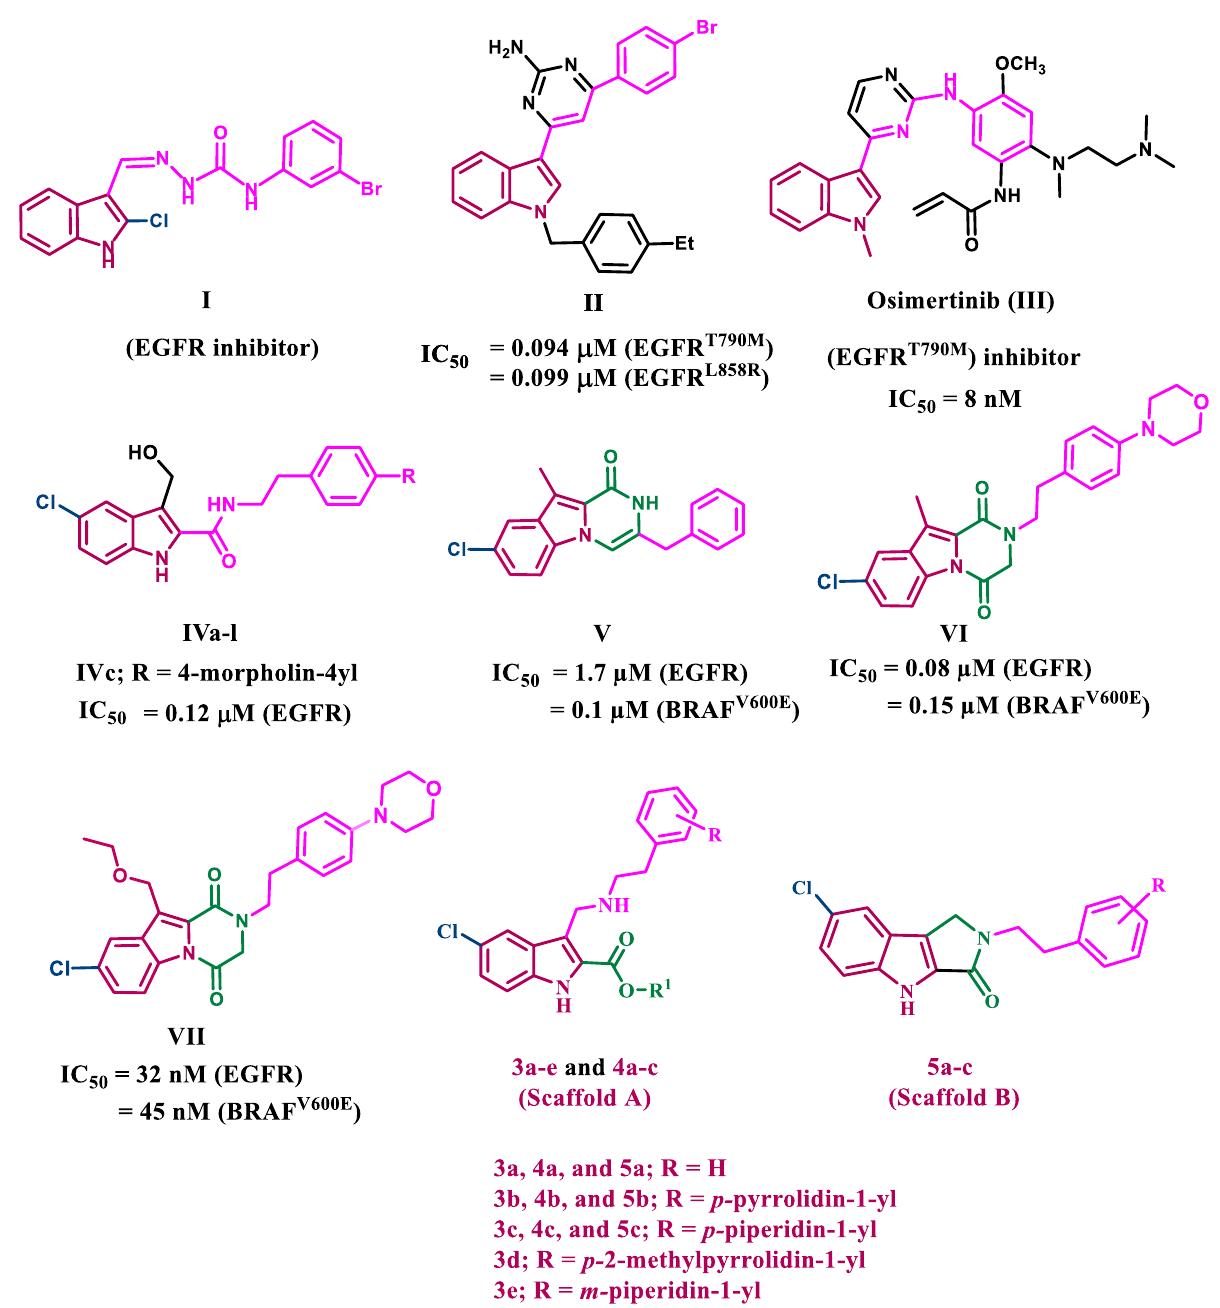
Figure 1. Structures of compounds I – VII and new targets 3a – e , 4a – c , and 5a – c .